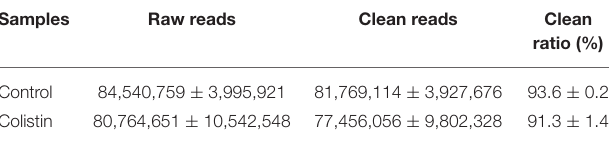
TABLE 1 | Statistical summary of the pig gut microbiome.